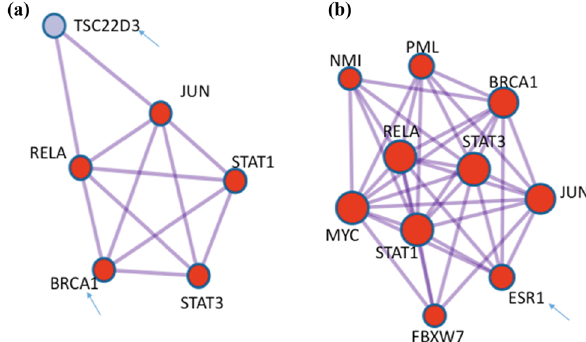
Figure 8: ( a ) Cytoscape representation of nodes and modules of critical hubs STAT3, RELA, STAT1, and JUN revealed by PIC - Venn analysis in the innate and adaptive immunity. ( b ) Regulation of critical nodes in the lung epithelial cells by SARS - CoV - 2. Regulation by steroid hormones was indicated by an